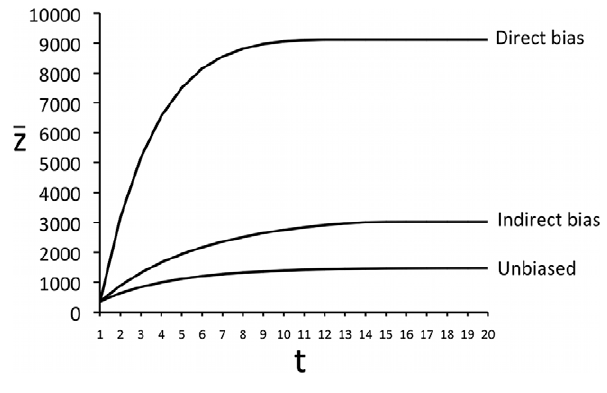
Figure 4. Time series of mean cultural complexity over time in Model 2 indicating that complexity reaches a maximum equilibrium Z max . Three alternative copying rules are shown: unbiased transmission (new individuals copy the cultural traits of a randomly selected member of the previous generation), indirectly biased transmission (new individuals copy the cultural traits of the member of the previous generation who had the highest individual fitness) and directly biased transmission (new individuals copy the cultural traits with the highest trait fitnesses across the entire previous generation). Parameters: N=100, c i =10, c s =5, l =1000, m i = m s =0; all results are the average of 100 independent runs.